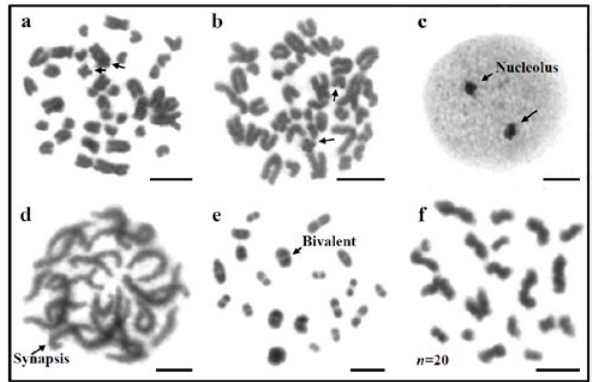
Fig. 4. Silver stained somatic metaphase complement of male (a) and female (b) of Cyrtodactylus kunyai , arrows indicate nucleo- lar organizer region (NOR), and meiotic cell division of the male C. kunyai on interphase by silver NOR staining (c), diplotene (d),